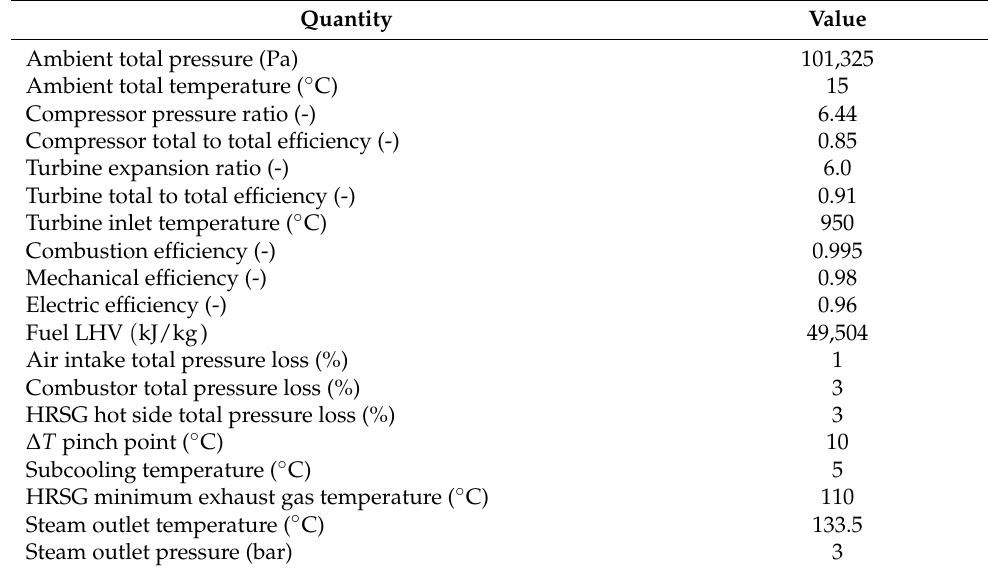
Table 1. Operational and performance parameters of the plant.